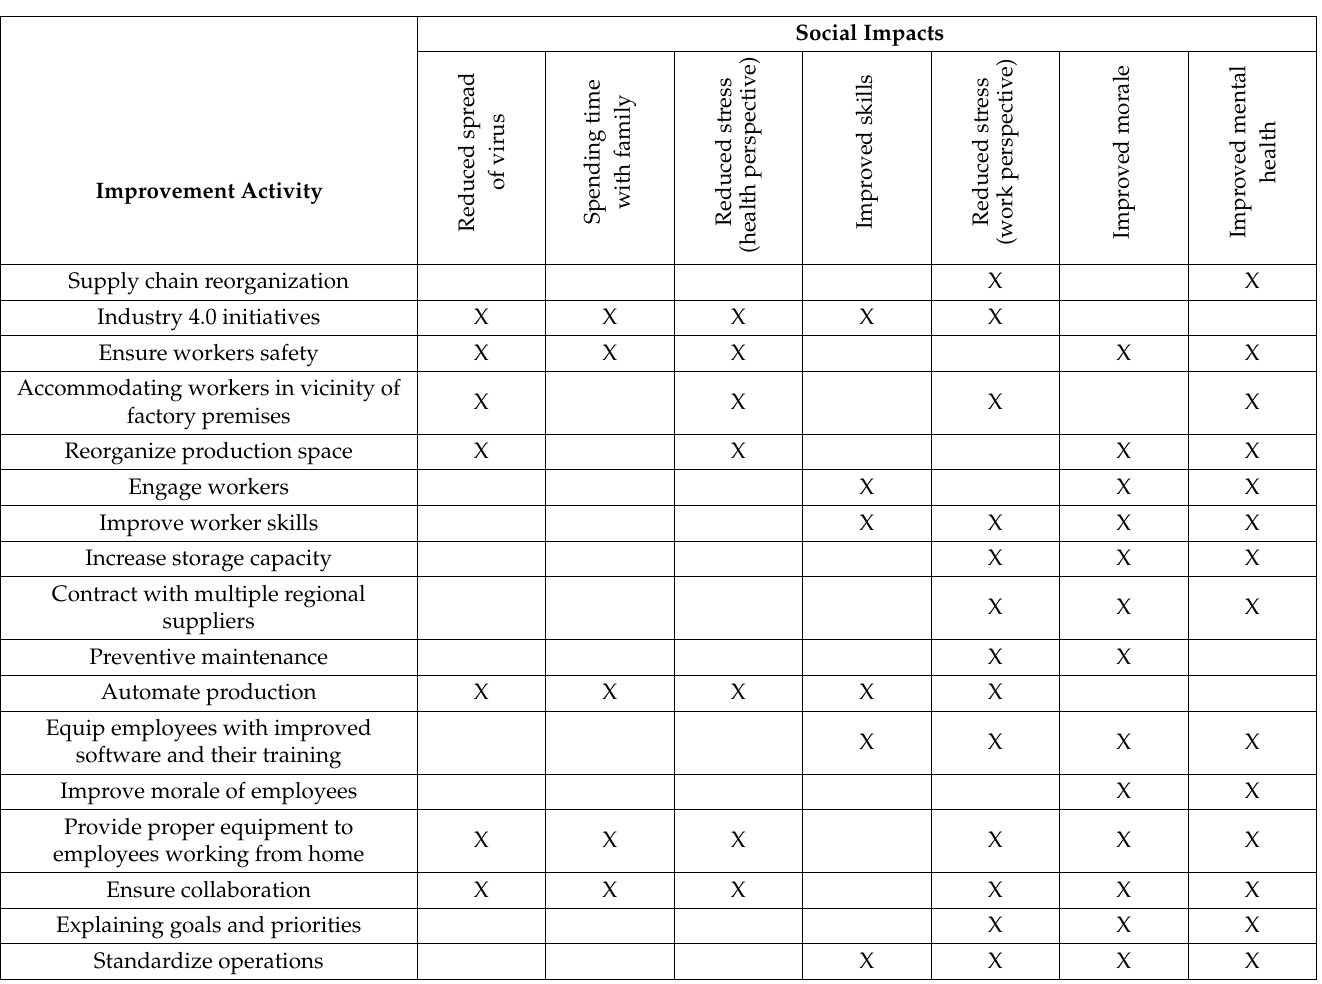
Table A6. Social assessment of improvement actions.